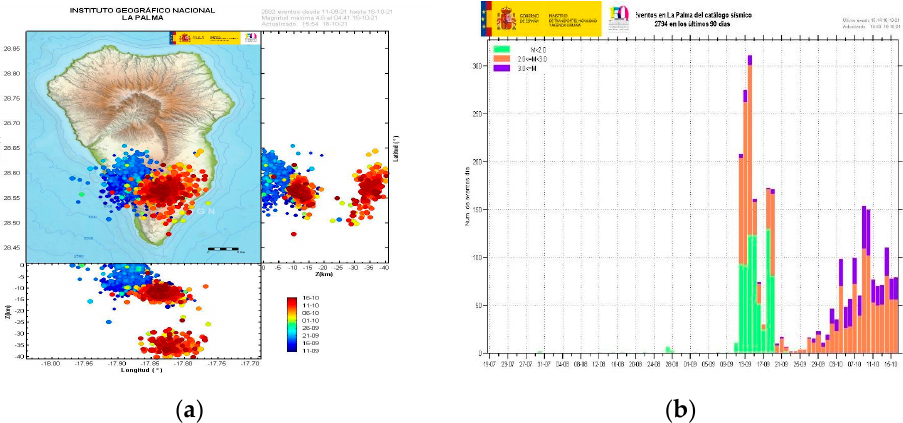
Figure 8. ( a ) Temporal and spatial evolution of the earthquakes preceding (blue color) the volcanic eruption that occurred on 19 September at La Palma Island [43]. ( b ) Temporal evolution of the number and magnitude of the earthquakes registered at La Palma Island [50].